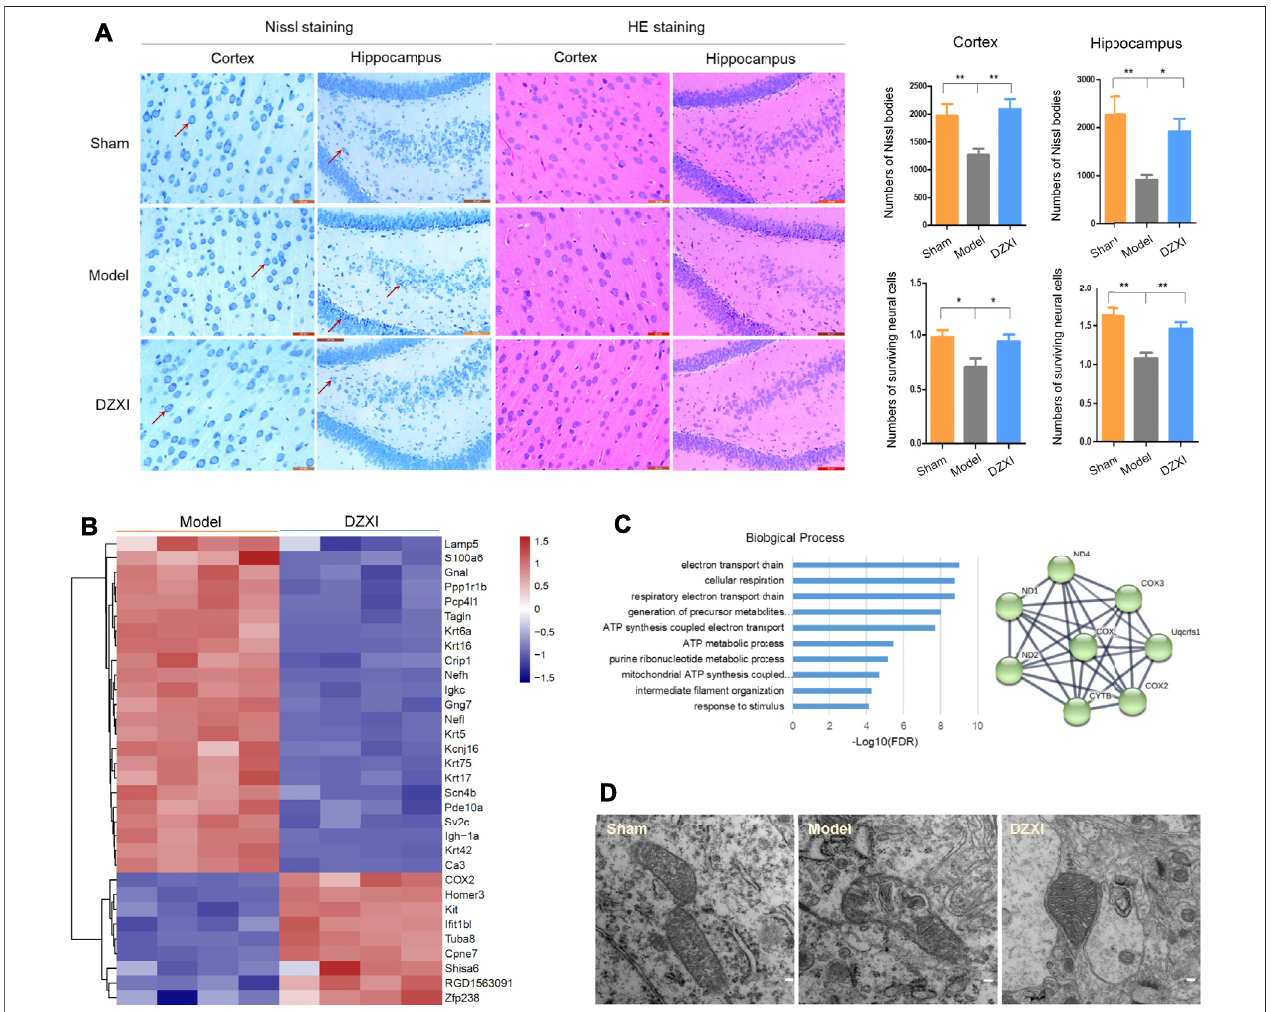
FIGURE6| DZXItreatmentprotectedneuralcellsandneuronalmitochondria. (A) Themorphologyofcorticalandhippocampal(dentategyrus)neuronsinDZXIand MCAO model groups were examined using Nissl staining and HE staining. The red arrows indicate the representative Nissl bodies. The numbers of Nissl bodies and survivingneuralcellsweremeasuredwithIPP6andanalyzedwithone-wayANOVAfollowedbytheNewman-Keulstest. n (cid:2) 6incortexand5inhippocampus, p p < 0.05, pp p < 0.01.Bars (cid:2) 20 μ mintheimagesofthecortexand50 μ mintheimagesofthehippocampus. (B) ThedifferentiallyexpressedproteinsbetweentheDZXIgroup and model group were identi fi ed in the proteomic assays, and their clustering fi gure was assessed by clustering analysis according to their expression levels. The TMT intensities (log 2 Z score transformed) of each protein (rows) in the model group and DZXI group (columns) was indicated on a coloured scale. (C) The top 10 biological processes in which the differentially expressed proteins between the model group and DZXI group were involved (left, acquired with GO analysis), and the interaction network of the electron transport chain (right, acquired with STRING). Colored nodes: query proteins and fi rst shell of interactors, edges represent protein-protein associations; line thickness indicates the strength of data support. COX2, cytochrome c oxidase subunit 2; COX3, cytochrome c oxidase subunit 3; ND1, NADH- ubiquinone oxidoreductase chain 1; ND2, NADH-ubiquinone oxidoreductase chain 2; ND4, NADH-ubiquinone oxidoreductase chain 4; CYTB, cytochrome b; Uqcfs1, cytochrome b-c1 complex subunit Rieske. (D) The morphology of neuron mitochondria was observed by using transmission electron microscopy at 7th day of treatment. Bar (cid:2) 100